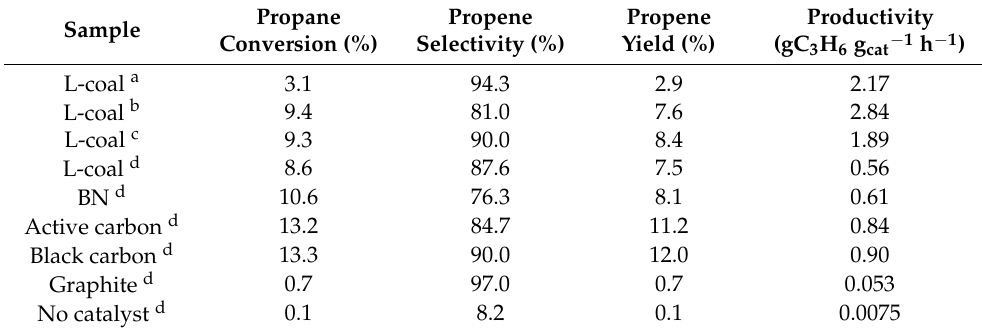
Table 1. The catalytic activities of various carbon-based catalysts and hexagonal boron nitride (BN). Sample